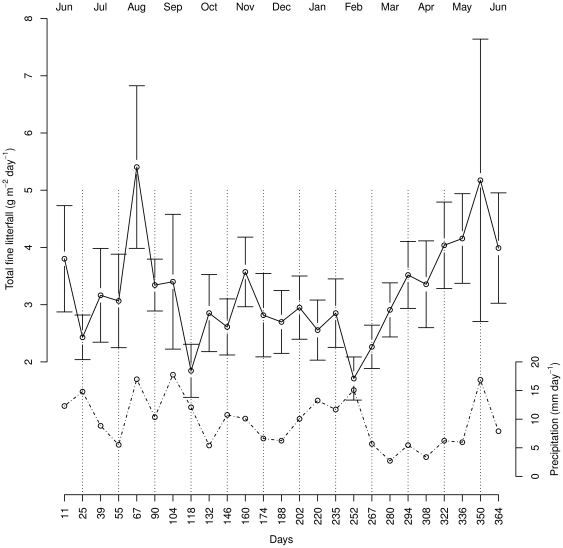
Monthly estimates of litterfall.Time series of total fine litterfall (solid line; mean±95% CI) and precipitation (dashed line; mean). Days indicate litter collections (n = 25) in 2006/07. Mean litterfall and rainfall were calculated over the fourteen days prior to collection.